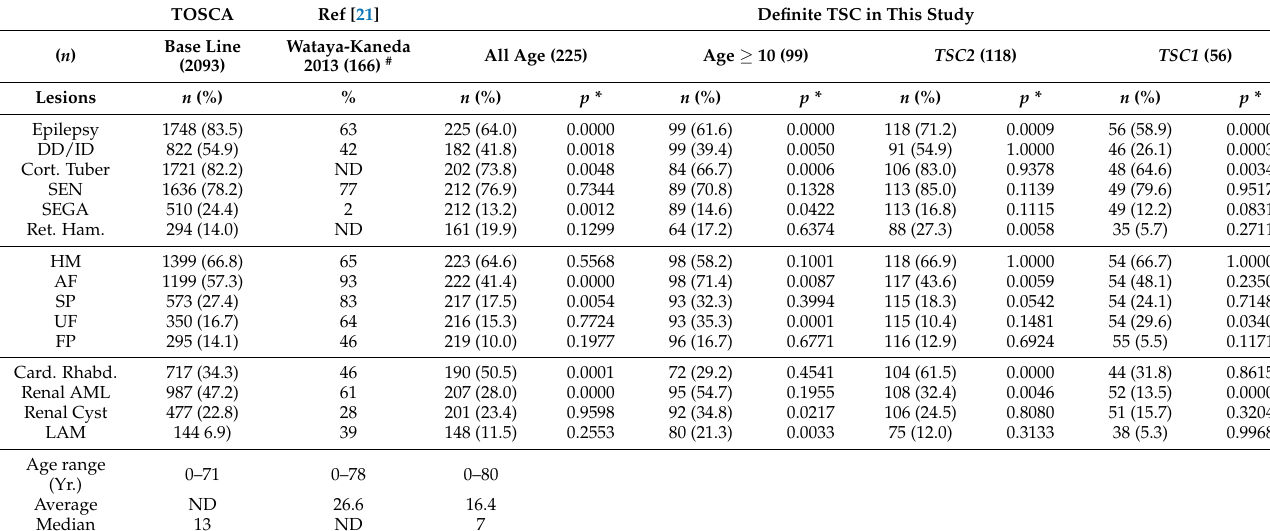
Table 2. Comparison of symptom and lesion prevalence between the TOSCA baseline, a previous Japanese study, and this